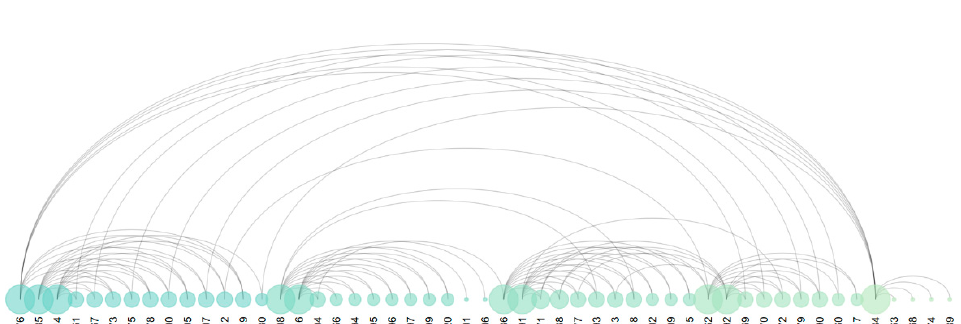
Figure 4. Similar years corresponding to the sample year of the wet season. Note: The arcs in the figure connect the sample year and its corresponding similar years. The size of the circle indicates the number of occurrences of the year.